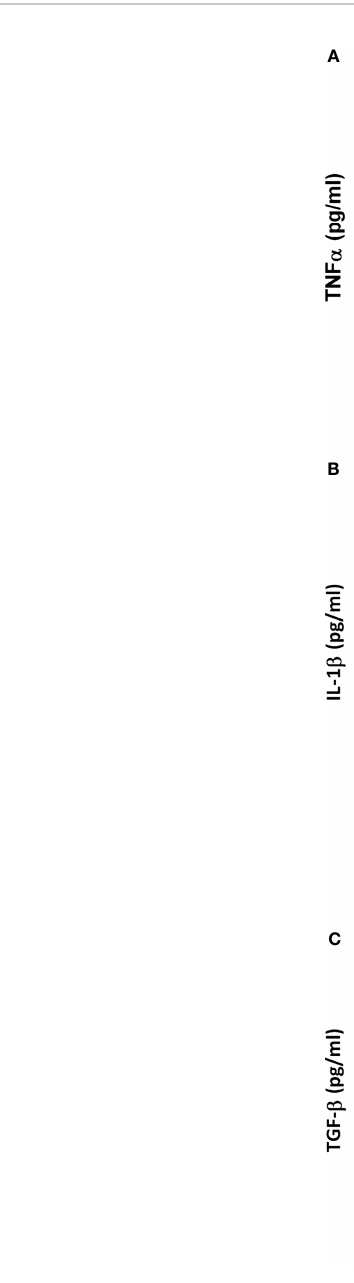
FIGURE 2 | ABL/PI5P and/or j BO1E stimulation modulates cytokine production in KKBO-1-infected human macrophages. dTHP-1 cells were infected or not with KPC-KP KKBO-1 clinical strain and then stimulated or not with ABL/PI5P and/or j BO1E for 18 h. Thereafter supernatants were collected and stored at − 20°C until analysis. The production of TNF- a (A) , IL-1 b (B) , and TGF- b (C) was analyzed by ELISA. The results are shown as mean ± standard deviation of the values obtained from triplicate of each condition and are representative of three different experiments. ** p < 0.01, *** p < 0.001 by Student ’ s t